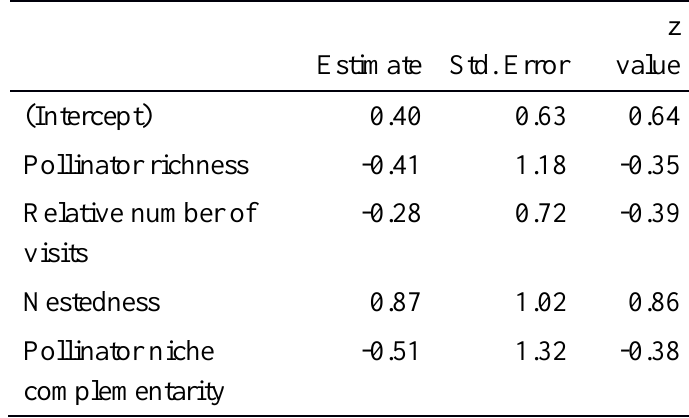
Table S6. Results of GLM showing effect of simple visitation metrics on equity in reproductive success across plant species within a site based on best model selected (0.50